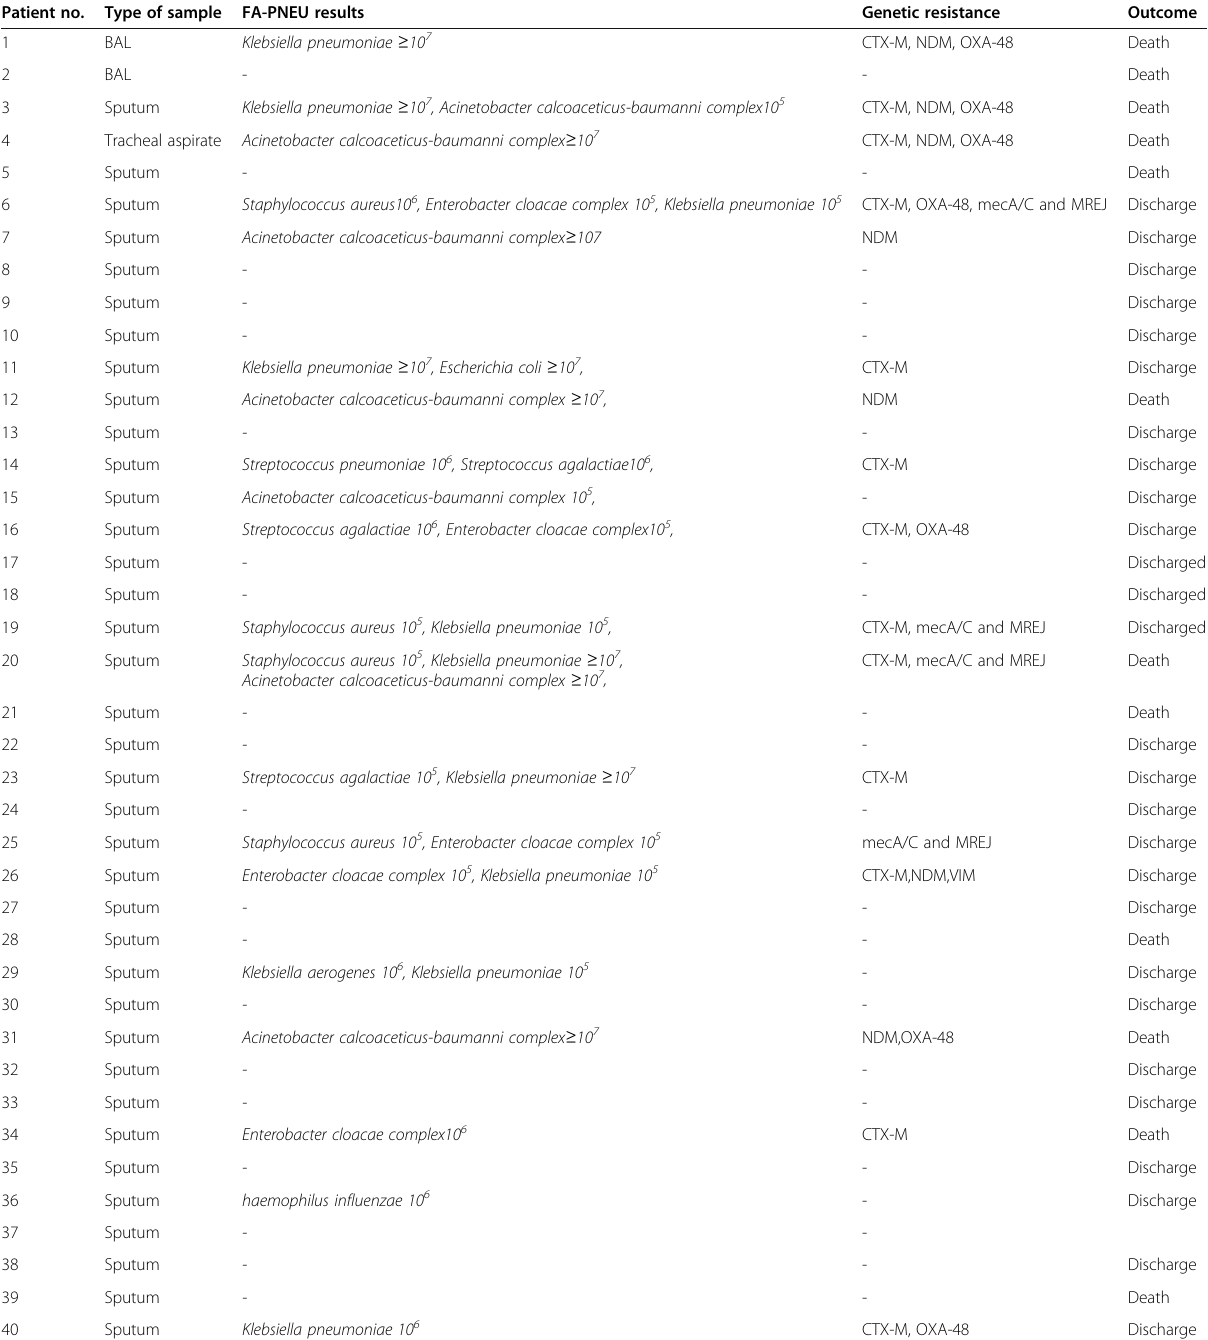
Table 3 Detailed PN panel results of included patients Patient no. Type of sample FA-PNEU